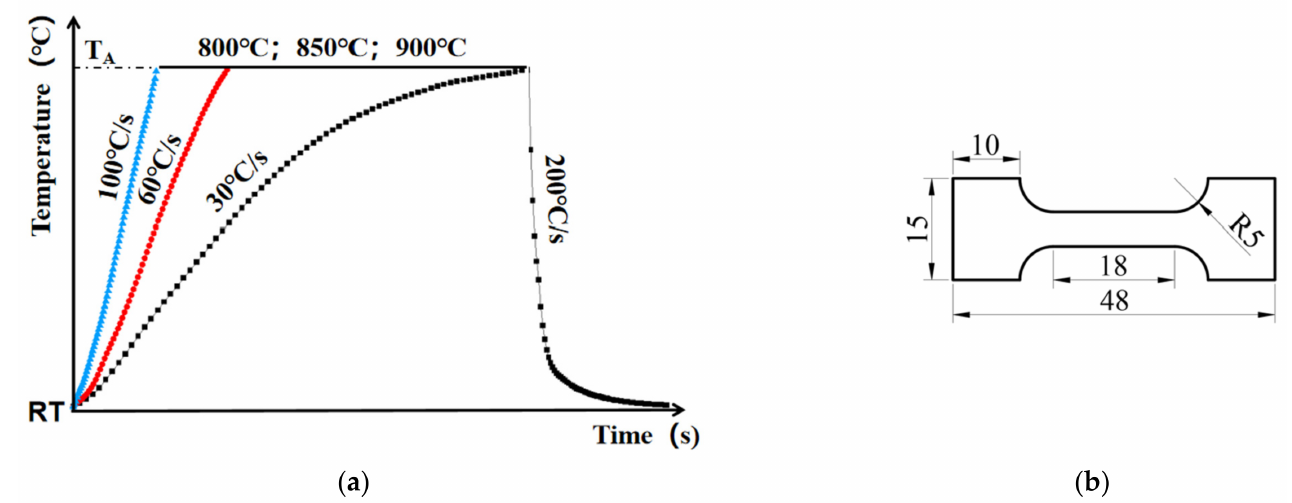
Figure 4. ( a ) Temperature histories of resistance heating experiments; ( b ) Geometry of the Gleeble tensile test specimens.